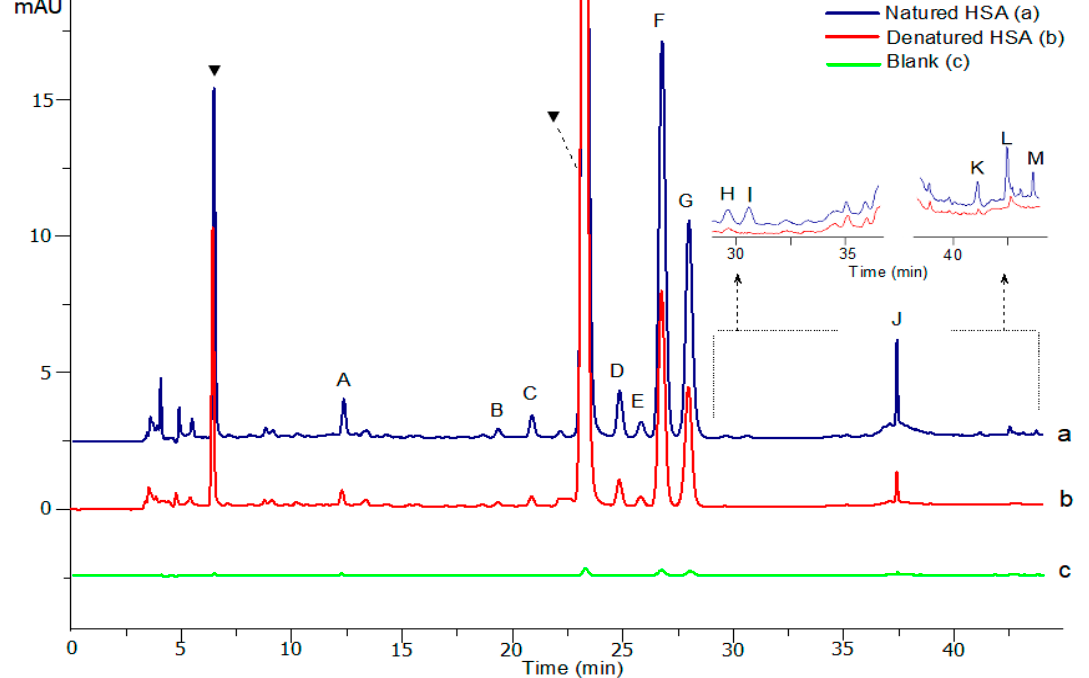
Figure 4. The high-performance liquid chromatography (HPLC) chromatograms for screening of the human serum albumin (HSA) ligands in Simo decoction (SMD) after ultrafiltration and dissociation procedures. The blue solid line represents HPLC profile of SMD sample mixed with natured HSA, and the red and green lines represent HPLC profiles of SMD sample mixed with denatured HSA and buffer solution, respectively. Bioactive ligands (A–M) were identified as norisoboldine (A), eriocitrin (B), neoeriocitrin (C), narirutin (D), hesperidin (E), narigin (F), neohesperidin (G), hesperidin-7- O - glucoside (H), linderane (I), neoponcirin (J), costunolide (K), nobiletin (L), and tangeretin (M), respectively. Triangle ( ▼ ) represents a compound with a high response but no specific binding named “frequent hitters”.